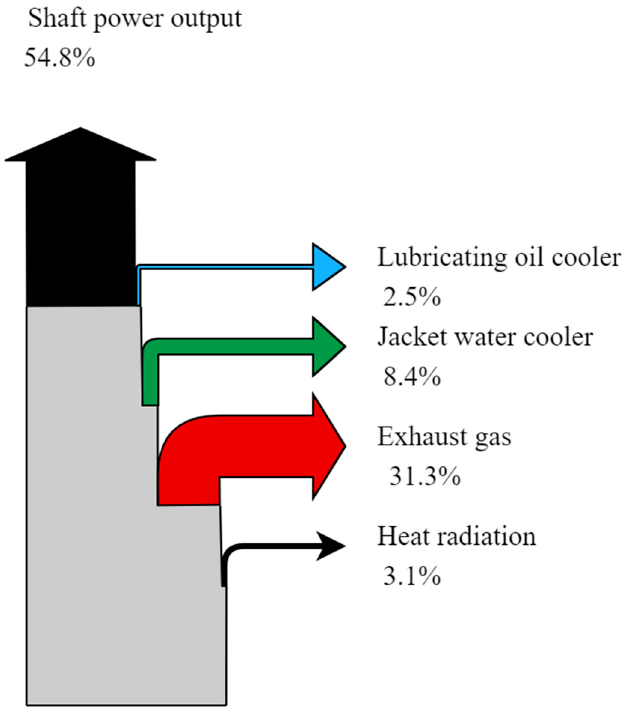
Figure 2. The fuel energy conversion diagram.